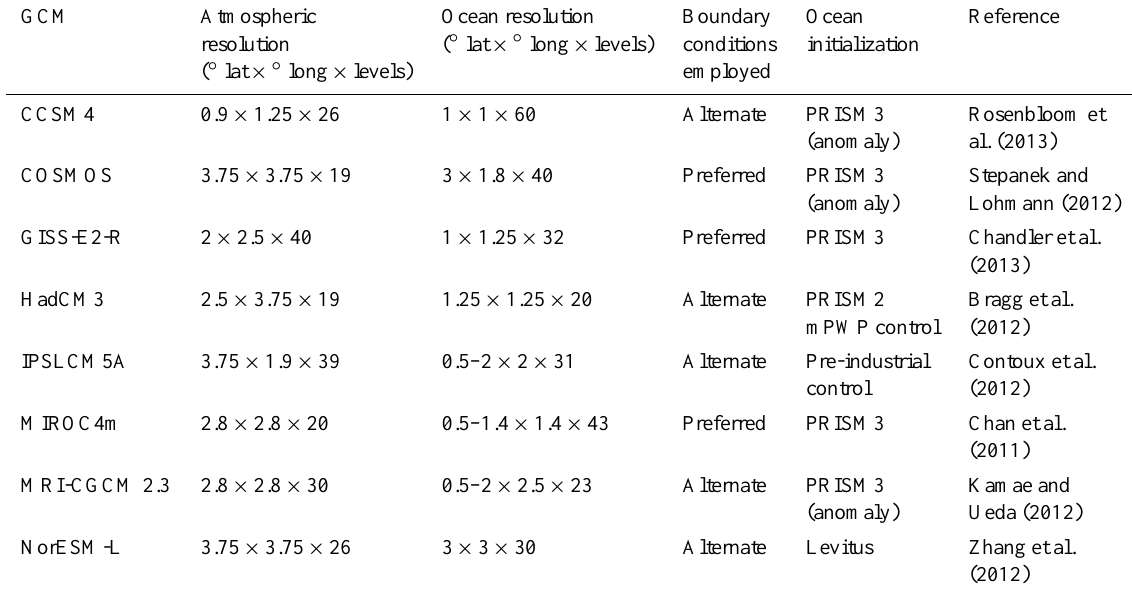
Table 1. Key model and experimental design parameters for each of the eight PlioMIP Experiment 2